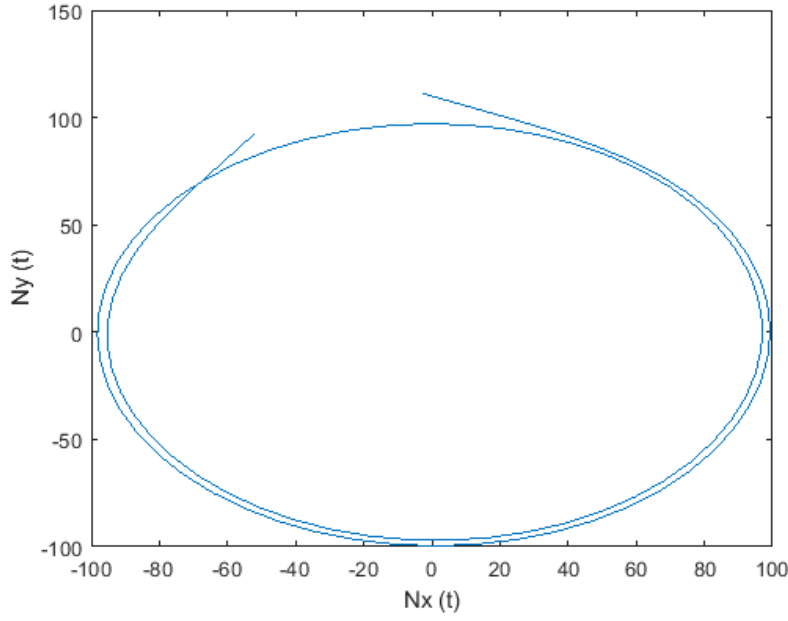
(cid:16) (cid:17) N x vs. N y with parameters: α = β =